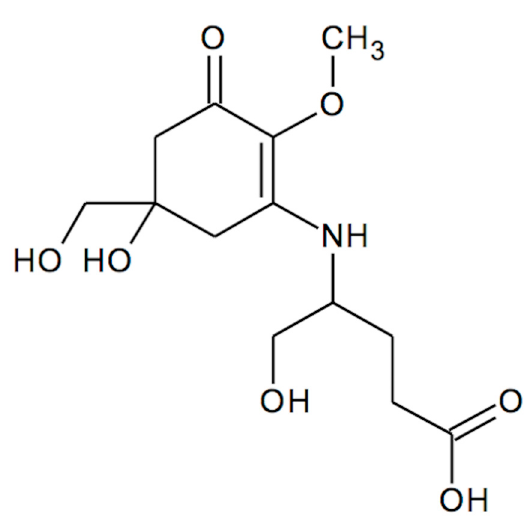
Figure 1. Myc-Glu(OH) chemical structure.